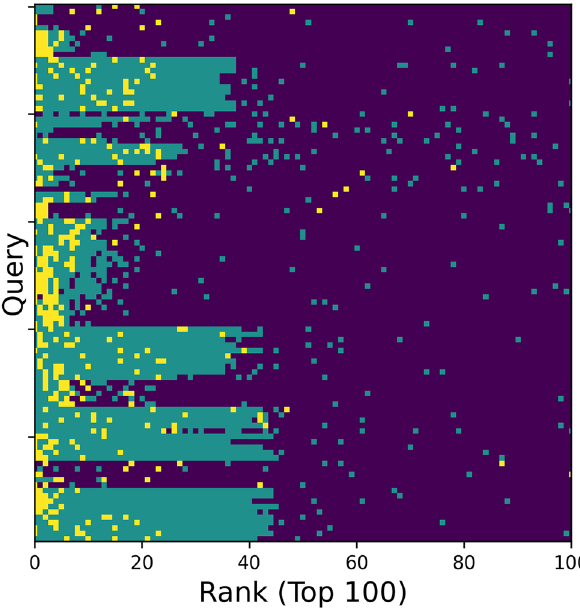
Fig. 4 Top 100 retrievals of partial map search. For 100 queries of partial map search that belong to a class with 10 or more members, top 100 retrieved maps were visualized in colors indicating whether the maps belong to the same group (yellow), the same class (green), or others (dark